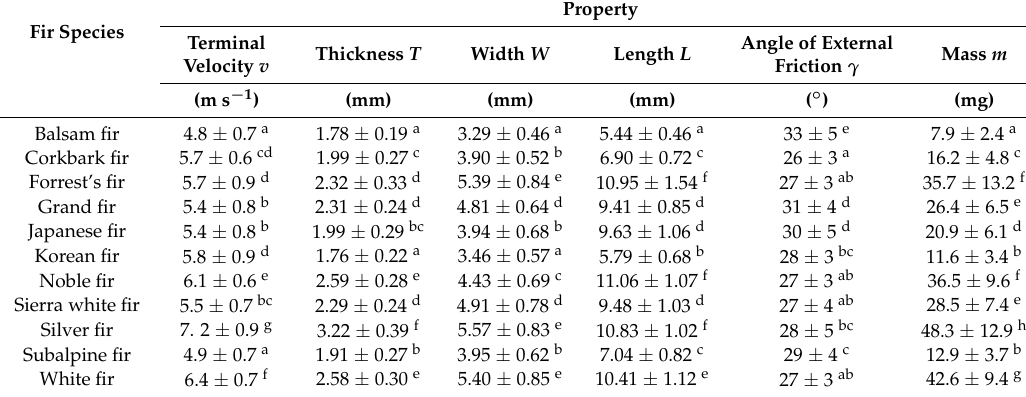
Table 1. Mean values ( ± standard deviation) of the physical properties of seeds of selected fir species. Superscript letters denote significant differences between properties at p < 0.05 (Duncan’s